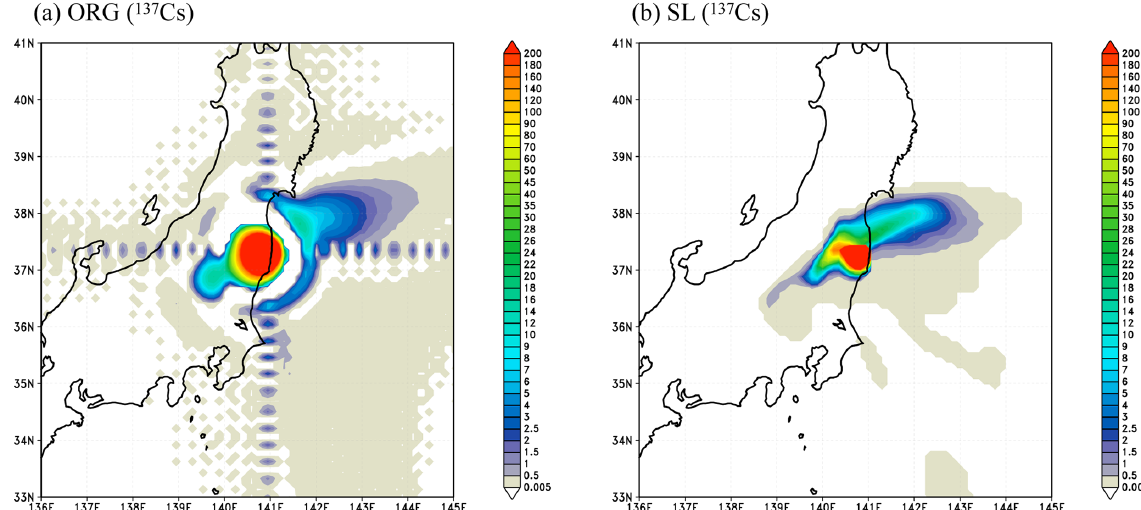
Figure 6. Simulated column-integrated atmospheric radioactive tracer (cesium-137, kBqm − 2 ) at 12:00UTC, 15 March